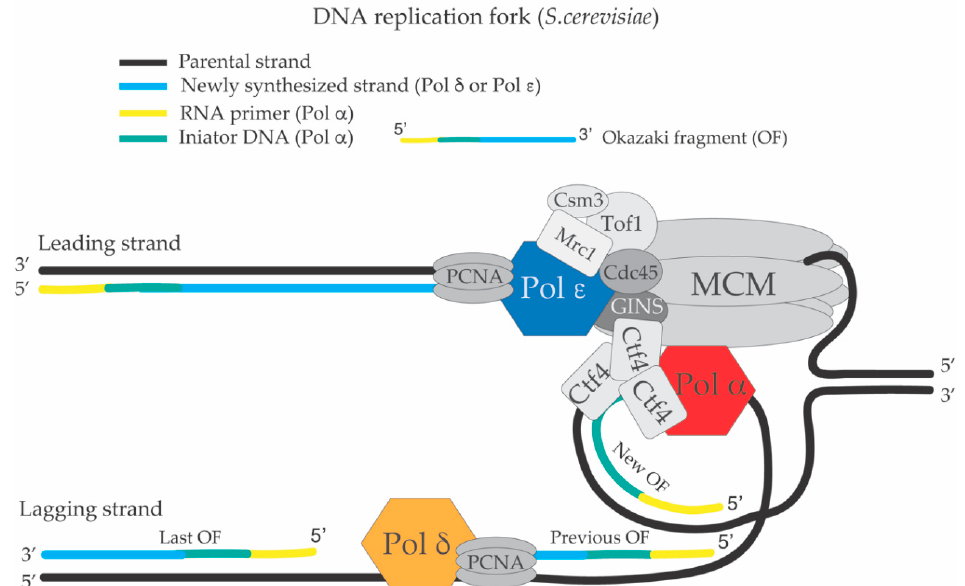
Figure 1. Schematic structure of the replisome and the DNA replication fork of S. cerevisiae. DNA polymerase ε synthesizes the leading strand continuously while DNA polymerase α -Primase and